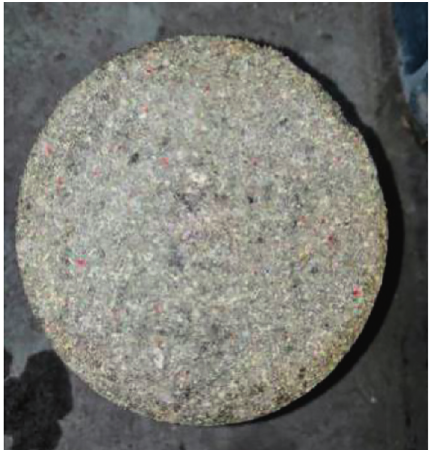
Figure 9: The sample before scouring.